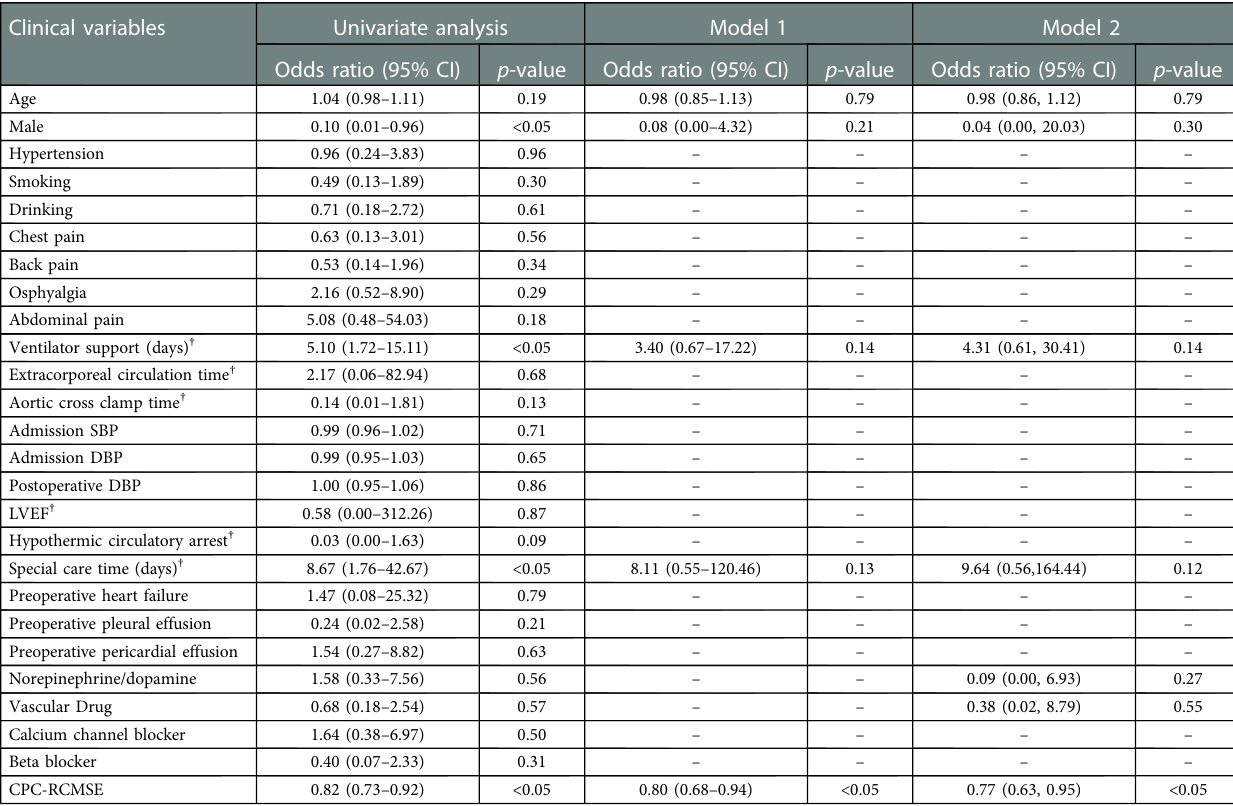
TABLE 2 Association of CPC-RCMSE with in-hospital complications.